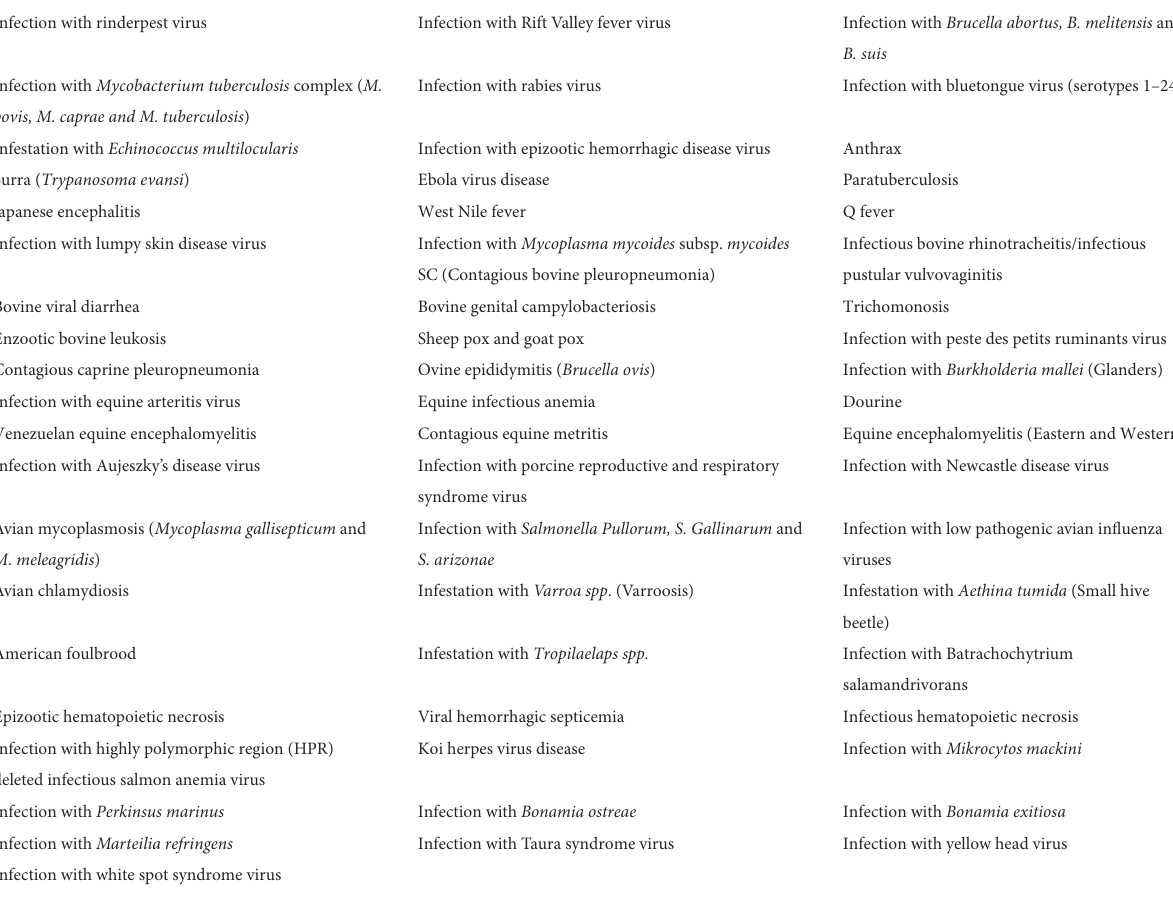
Infection with rinderpest virus Infection with Rift Valley fever virus Infection with Brucella abortus, B. melitensis and